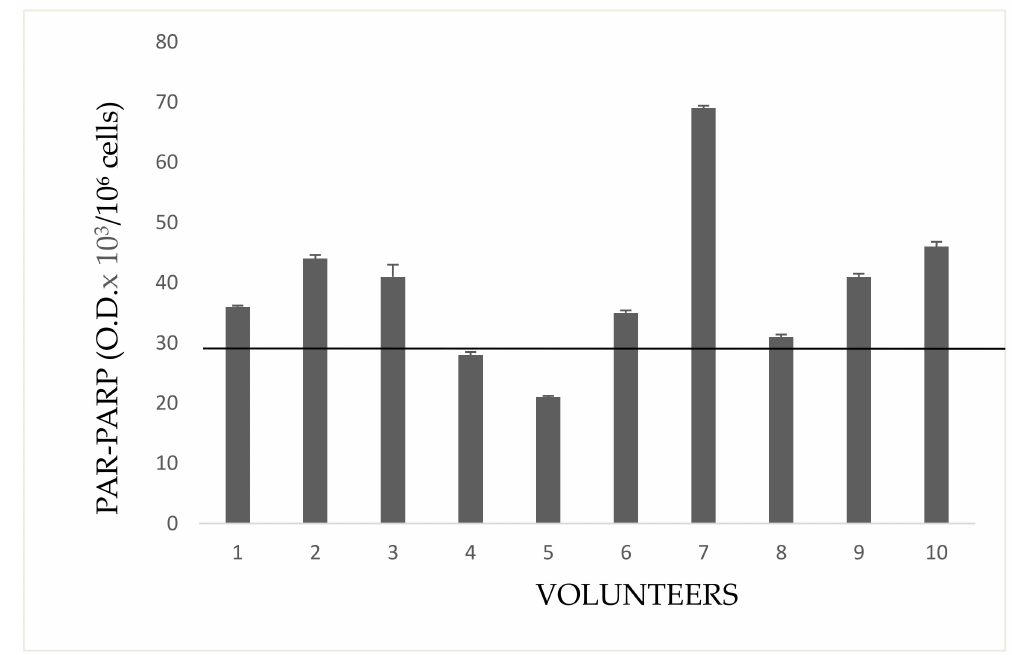
Figure 7. PAR-PARP in indirectly exposed subjects. The black line is the cut-off. Mean values of duplicate measures from two different lysate